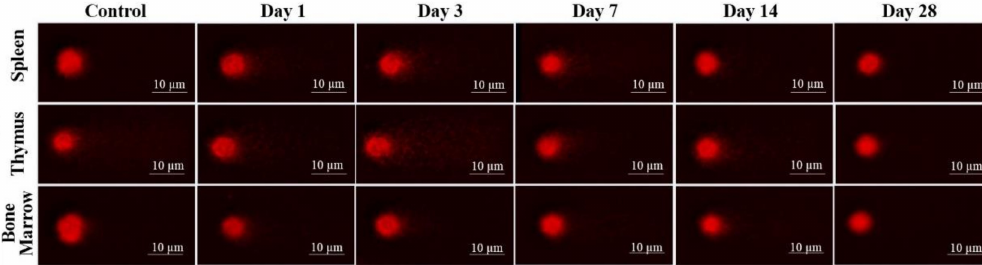
Figure 8. DNA damage induced by low-energy ultrashort-pulsed electron beam irradiation in vivo in rats; results of comet assay in spleen ( a ), thymus ( b ), and bone marrow ( c ) cells. *** p < 0.001; **** p < 0.0001 (compared to control).